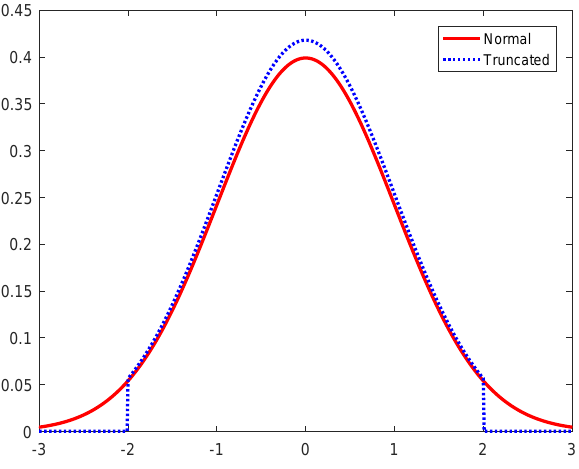
Figure 8. Truncated Gaussian distribution and Gaussian distribution.